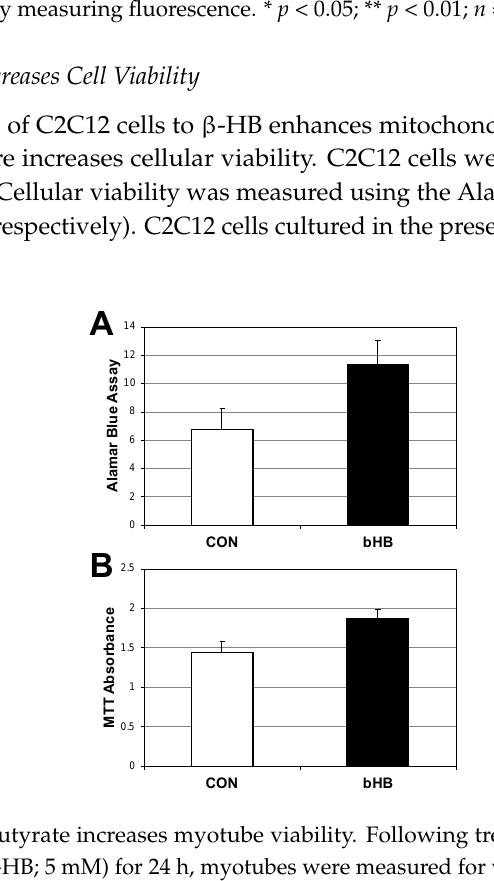
Figure 1. β -Hydroxybutyrate favorably alters mitochondrial function. C2C12 myotubes were treated with PBS (CON) or with β -Hydroxybutyrate ( β -HB; 5 mM) for 24 h. To measure mitochondrial respiration ( A ), cells were treated with GM L : glutamate (10 mM) + malate (2 mM); GM D : + ADP (2.5 mM); GMS D : + succinate (10 mM); GMS F : + FCCP (0.05 μ M). Respiratory control ratio (( B ); RCR; GM D /GM L ) and uncoupling control ratio (( C ); UCR; GMS F /GMS D ) were determined from the respiration assay. ATP production ( D ), ATP:O 2 ratio (P:O; ( E ), H 2 O 2 production ( F ) and H 2 O 2 :O 2 ratio ( G ) were determined by measuring fluorescence. * p < 0.05; ** p < 0.01; n = 6.